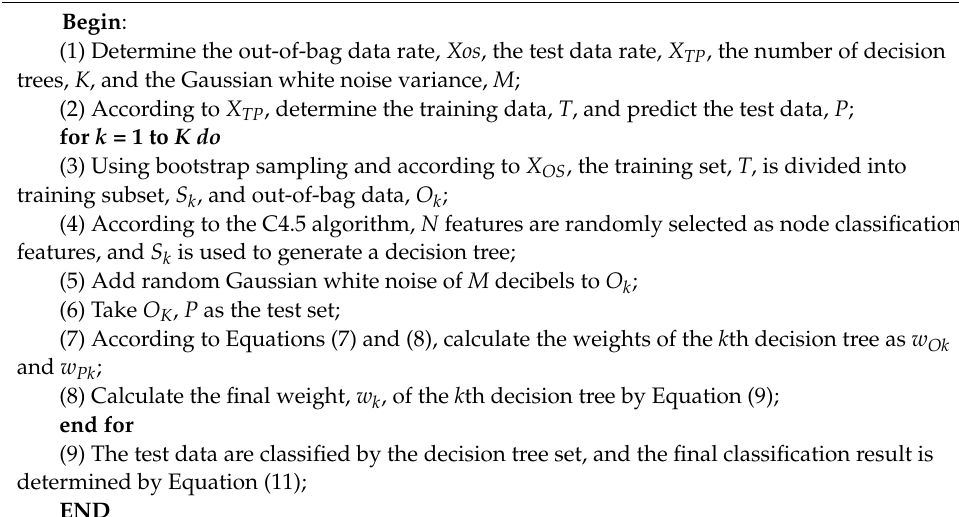
Algorithm 1: Improved Random Forest